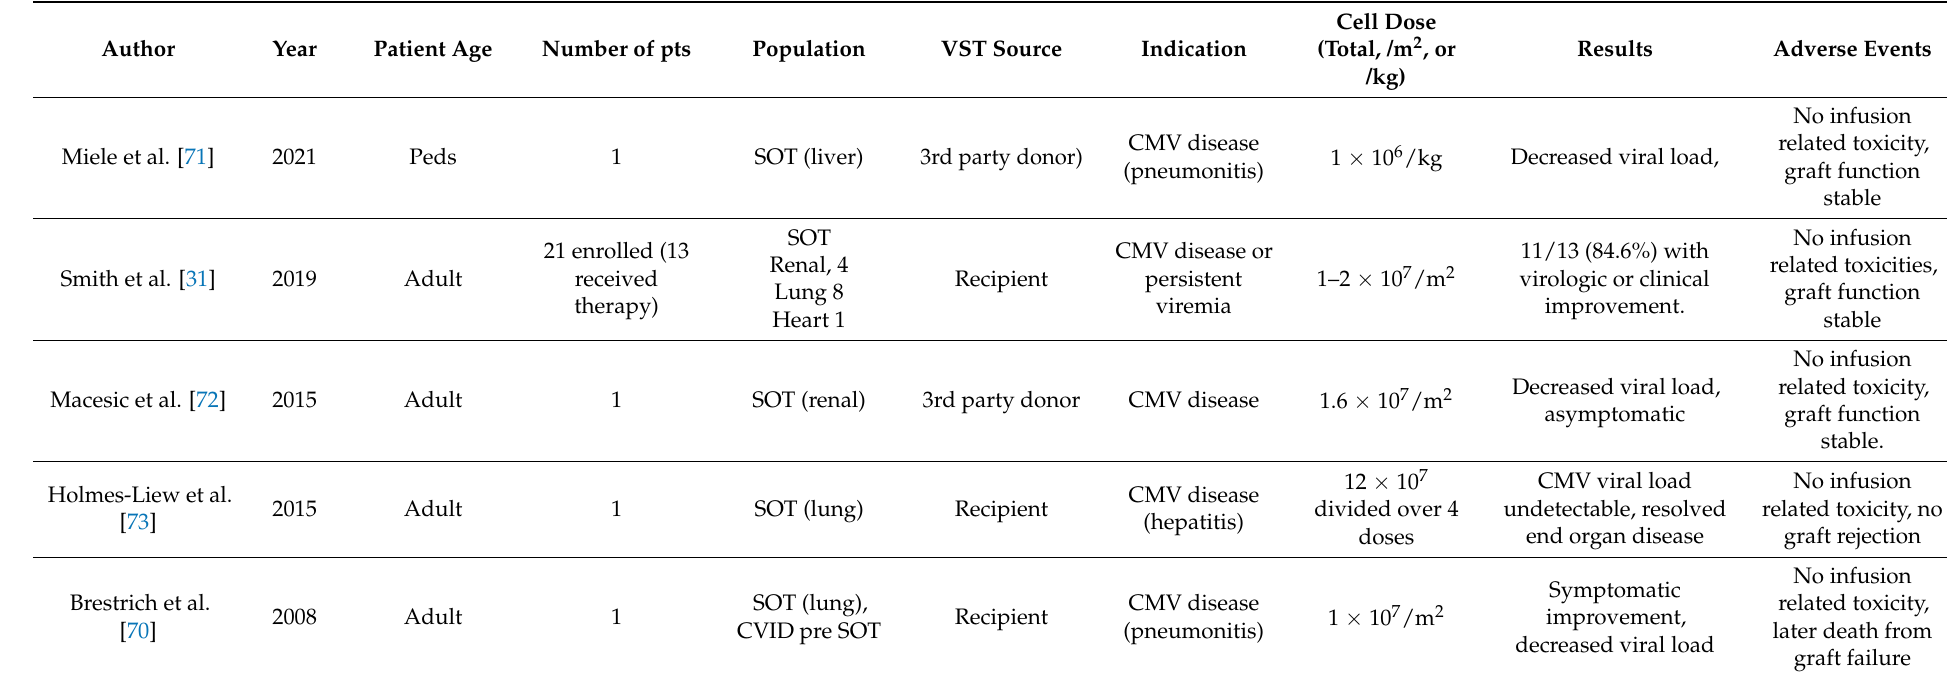
Table 2. Adoptive Immunotherapy for Treatment of Cytomegalovirus Infection or Disease in SOT